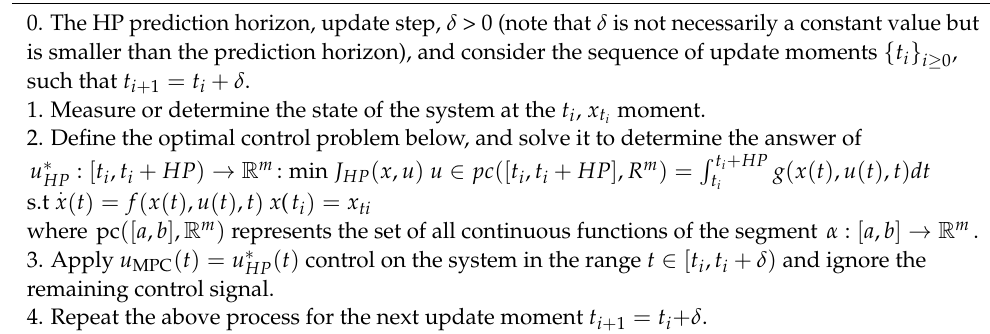
Algorithm 1: Predictive controller for continuous-time systems (1) and